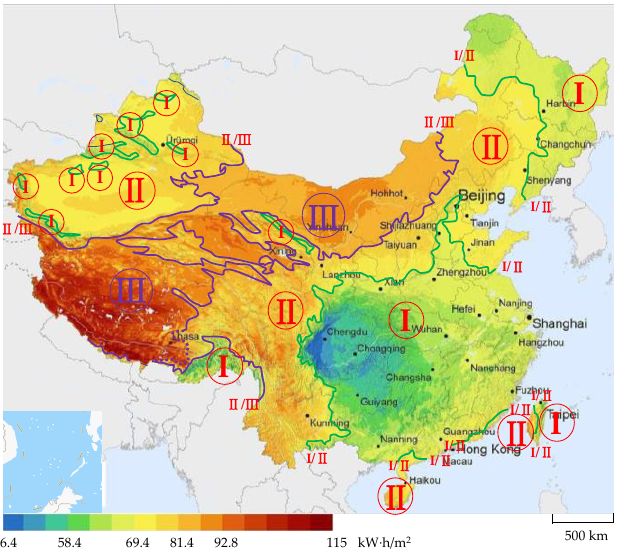
Figure 3. Climatic zoning of asphalt UV radiation in China (I/II is the boundary between zone I and zone II; II/III is the boundary between area II and area III).